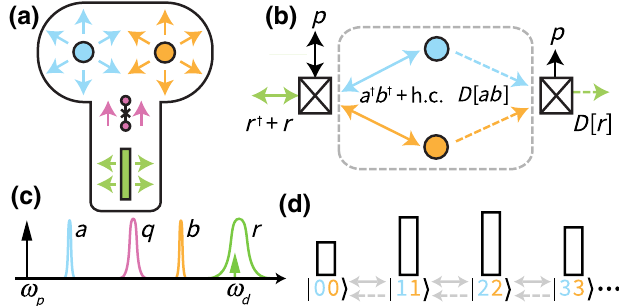
FIG. 1. PCS generation: the system and protocol. (a) Cartoon of the 3D cQED system containing two high- Q cylindrical- post cavities a and b (blue and orange), the transmon ancilla q (magenta), and the strip-line low- Q reservoir r (green). (b) The four-wave mixing pump p , with frequency ω p ≈ ω a + ω b − ω r , coherently converts reservoir excitations with pairs of a and b excitations mediated by the ancilla junction. The ancilla junction also converts the reservoir decay (dotted green arrow) into an effective pair-photon dissipative process (dotted blue and orange arrows). Note that the two drawings of the junction depict two processes that happen with the same junction. After adiabatic elimination of the reservoir, the storage-cavity dynamics are shown in the dotted box. (c) Cartoon of the mode frequencies and line widths (not to scale). The strong off-resonance pump tone p and the weak on-resonance ( ω d ≈ ω r ) reservoir drive d are shown as vertical arrows. (d) A schematic diagram of δ = 0 states under pair-photon drive (double-headed arrow) and pair dissipation (dotted arrow). Fock states are written as | n a n b (cid:2) and the vertical bars represent a PCS